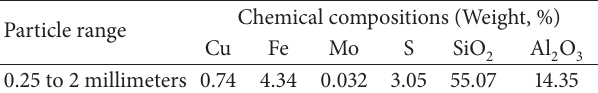
Table 1: Chemical composition of the Sarcheshmeh ore sample (Wt %).